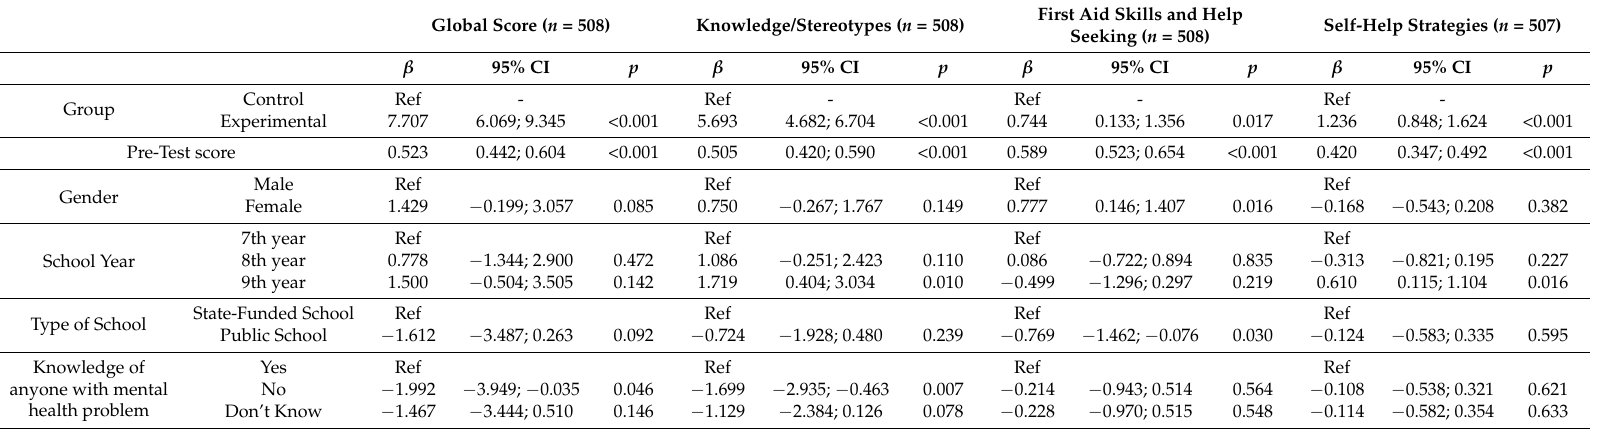
Table 3. Study of intervention effectiveness and the differential impact of sociodemographic variables based on Generalized Estimating Equations using repeated measurements (pre, post and follow-up) adjusted for some variables (Pre-test scores, Gender, School Year, Type of School and knowledge of anyone with a mental health problem) for global score and dimensions of mental health literacy. First Aid Skills and Help Global Score ( n = 508) Knowledge/Stereotypes ( n = 508) Seeking ( n =